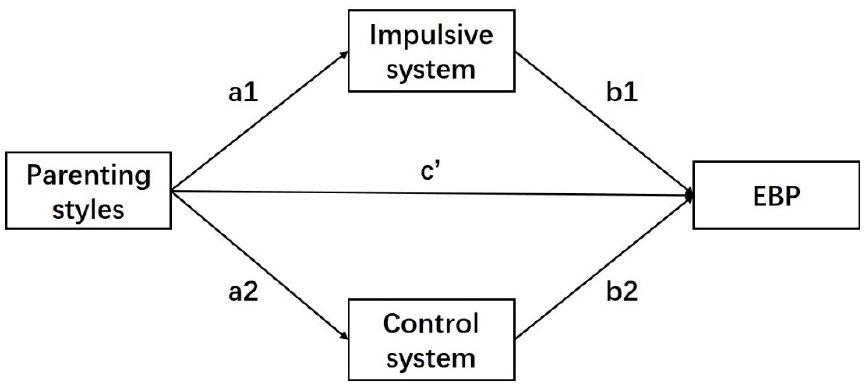
Figure 1. Parallel mediation model for impulsive system and control system. Note: a1, b1, a2, b2 and c’ present the standardized path coefficients.